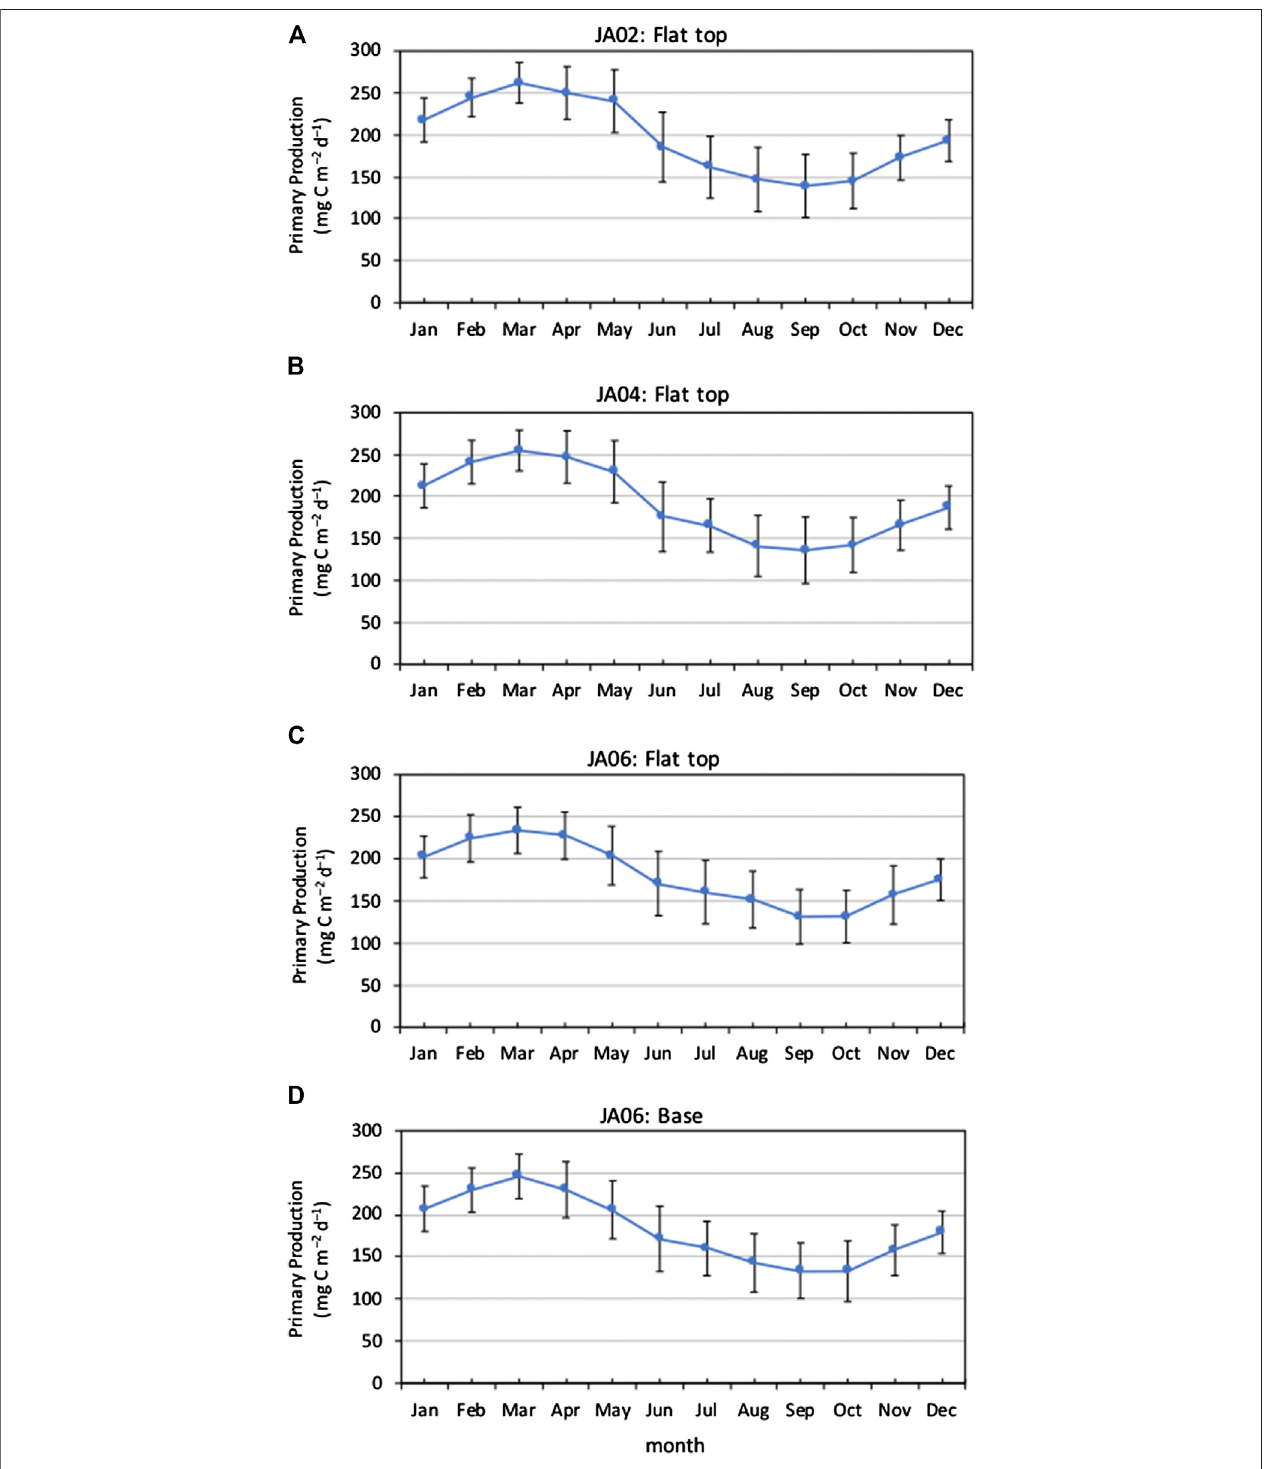
FIGURE 5 | Annual climatology of satellite-based net primary production for the period 2002 – 2018 around the (A) JA02, (B) JA04, and (C,D) JA06 seamounts.